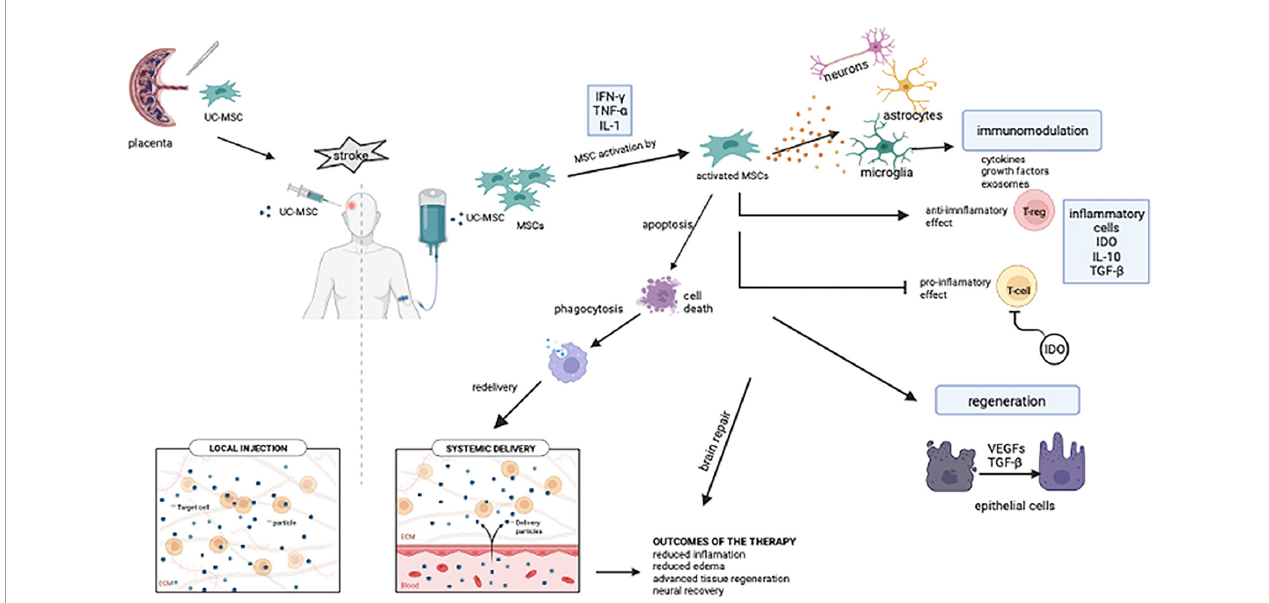
FIGURE3 Intravenous MSC-mediated immunomodulation and tissue recovery potential mechanisms. Stroke patients received intravenous injections of mesenchymal stem cells obtained from the umbilical cord. Pro-inflammatory factors such as IL-1, IFN γ , and TNF- α facilitate MSC activation. Microglia, which are activated after MSCs are transplanted, contribute to the neuro repair of the brain by inducing an inflammatory response. IDO, which is expressed from MSCs, inhibits T cell growth. MSCs modulate the immune system with cytokines, growth factors, and exosomes. MSCs, respond to their surroundings by producing growth and differentiation factors and contributes to tissue remodeling after transplantation. Despite intravenously transplanted cells having a short half-life, their cellular residues can be phagocytosed and transported to various parts of the body via the bloodstream (UC-MSC, umbilical cord mesenchymal stem cell; MSC, mesenchymal stem cell; IFN- γ , interferon-gamma; TNF- α , tumor necrosis factor- α ; IL-1, IL-10, interleukin family; IDO, indoleamine 2,3-dioxygenase; T-reg, regulatory T cell; TGF- β , transforming growth factor beta; VEGFs, vascular endothelial growth factors). Created with